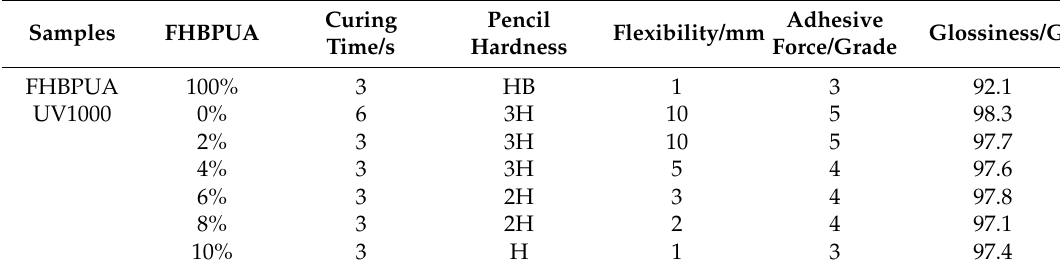
Table 1. Properties of UV-cured films of FHBPUA and UV1000